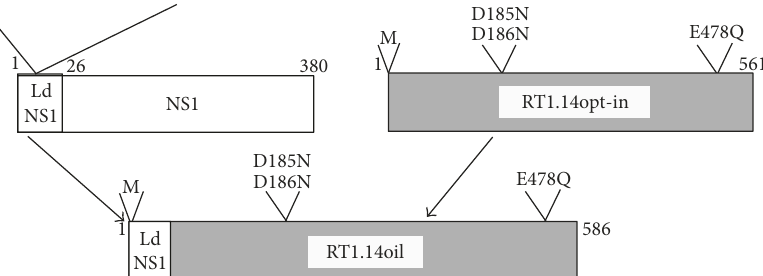
Figure 1: Schematic representation of chimeric drug-resistant HIV-1 reverse transcriptase carrying the N-terminal insertion of the N- terminal signal peptide of NS1 protein of TBEV (RT1.14oil). Rectangular boxes stand for polypeptide chains of NS1 with leader signal peptide (white) and RT1.14opt-in sequence (gray) with amino acid substitutions in polymerase (D185N, D186N) and RNase H signature motives (E478Q) leading to inactivation of respective enzymatic activities in the resultant RT1.14oil polyprotein. Amino acid positions in the polypeptide chain are designated with numbers.